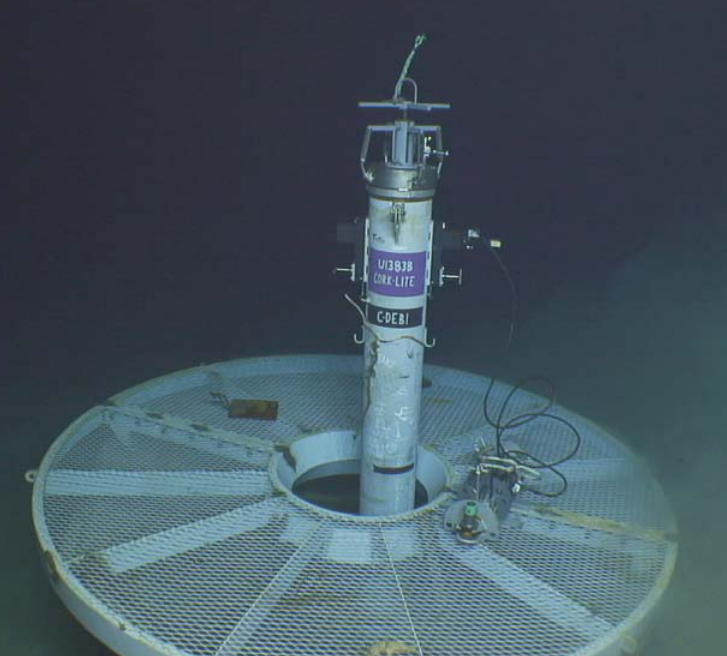
Figure 4. A CORK-Lite was successfully deployed and instrumented in IODP Hole U1383B. The cap (silver material above the gray pipe) is secured to the body utilizing the handle with a short piece of rope that originally was connected to flotation. The pressure logger rests on the ROV platform and is connected to the CORK-Lite body.